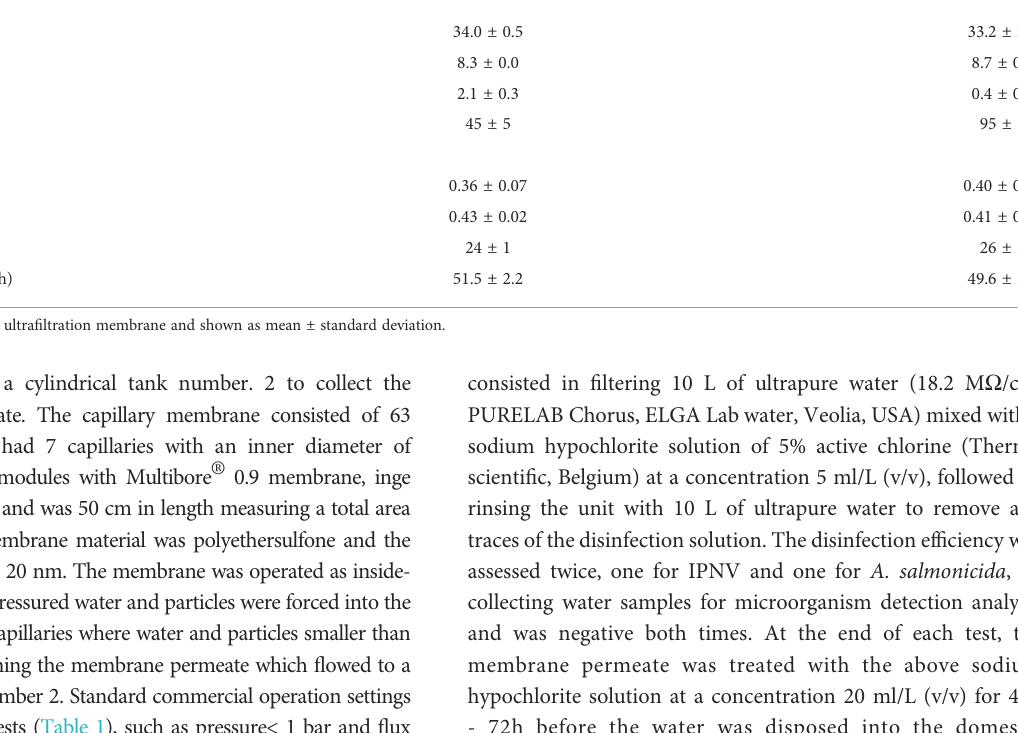
TABLE 1 Water quality and operation conditions during ultra fi ltration membrane test.